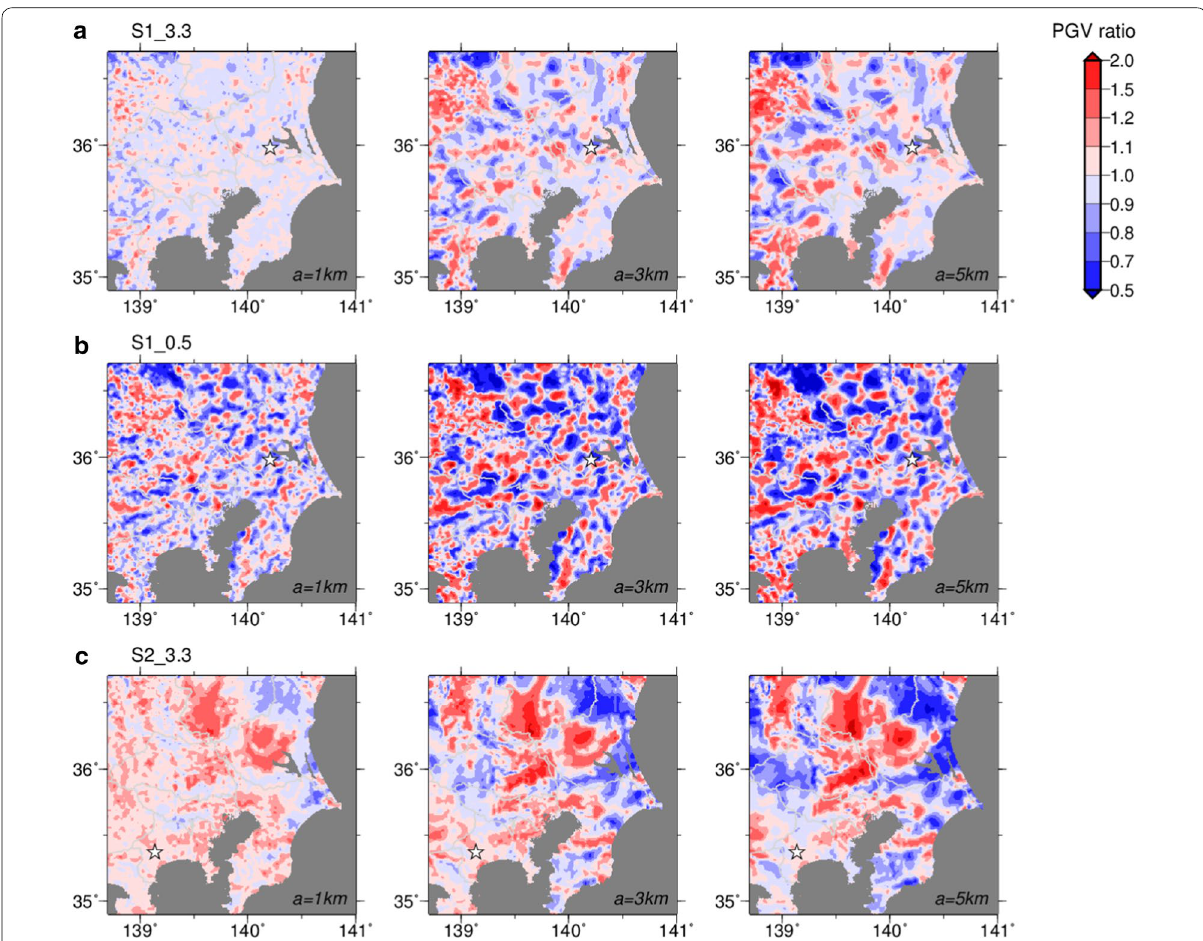
Fig. 6 Ratio of PGV for homogeneous to heterogeneous velocity models ( a Epicenters are denoted by